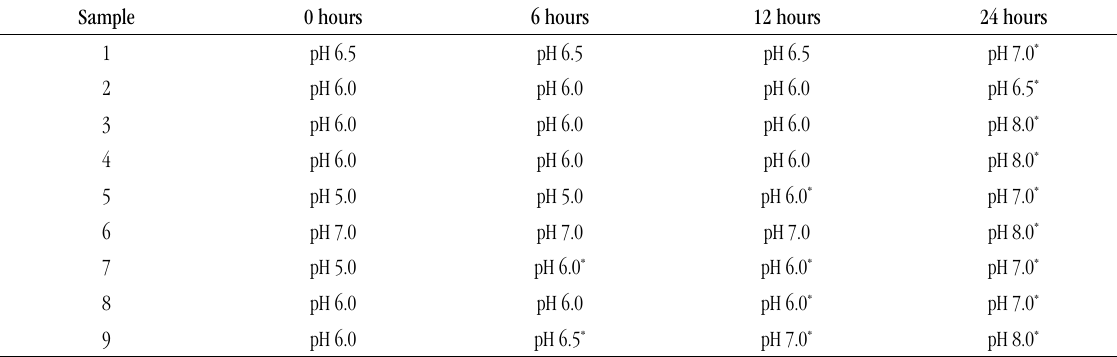
tABLE 3 – Reactive strip results related to pH in urine samples with changes and kept at room temperature